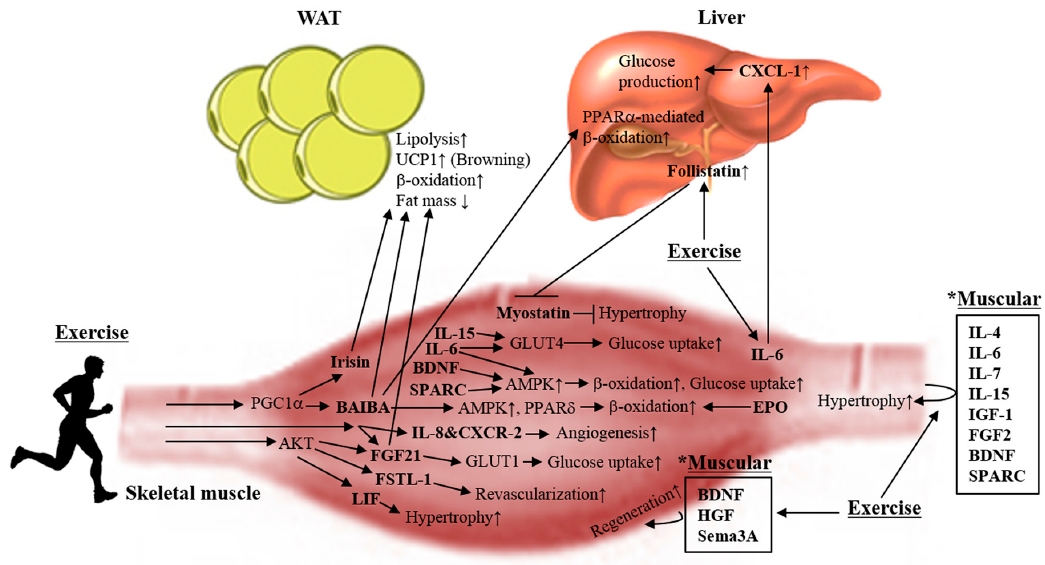
Figure 2. Exercise-induced myokines play critical roles in beneficial metabolic adaptations. Contracting skeletal muscles release myokines, and promote hypertrophy and myogenesis within muscle itself. The action of myokines for exercise-induced metabolic adaptation is responsible for promoting glucose uptake, glucose disposal, lipolysis, β -oxidation, angiogenesis, and revascularization. Subsequently, they exert systemic effects that improve lipid and glucose metabolism in white adipose tissue (WAT) and the liver. Specifically, muscular irisin, β -aminoisobutyric acid (BAIBA) and fibroblast growth factor 21 (FGF21) lead to the induction of “browning” in WAT that can counteract obesity and its associated metabolic diseases. UCP1: uncoupling protein 1; PGC1 α : peroxisome proliferator-activated receptor gamma coactivator 1- α ; FSTL-1: follistatin-related protein 1; LIF: leukemia inhibitory factor; BDNF: brain-derived neurotrophic factor; SPARC: secreted protein acidic and rich in cysteine; AMPK: AMP-activated protein kinase; PPAR δ : peroxisome proliferator-activated receptor delta; GLUT1: glucose transporter 1; GLUT4: glucose transporter 4; CXCR-2: CXC chemokine receptor-2; CXCL-1: CXC chemokine